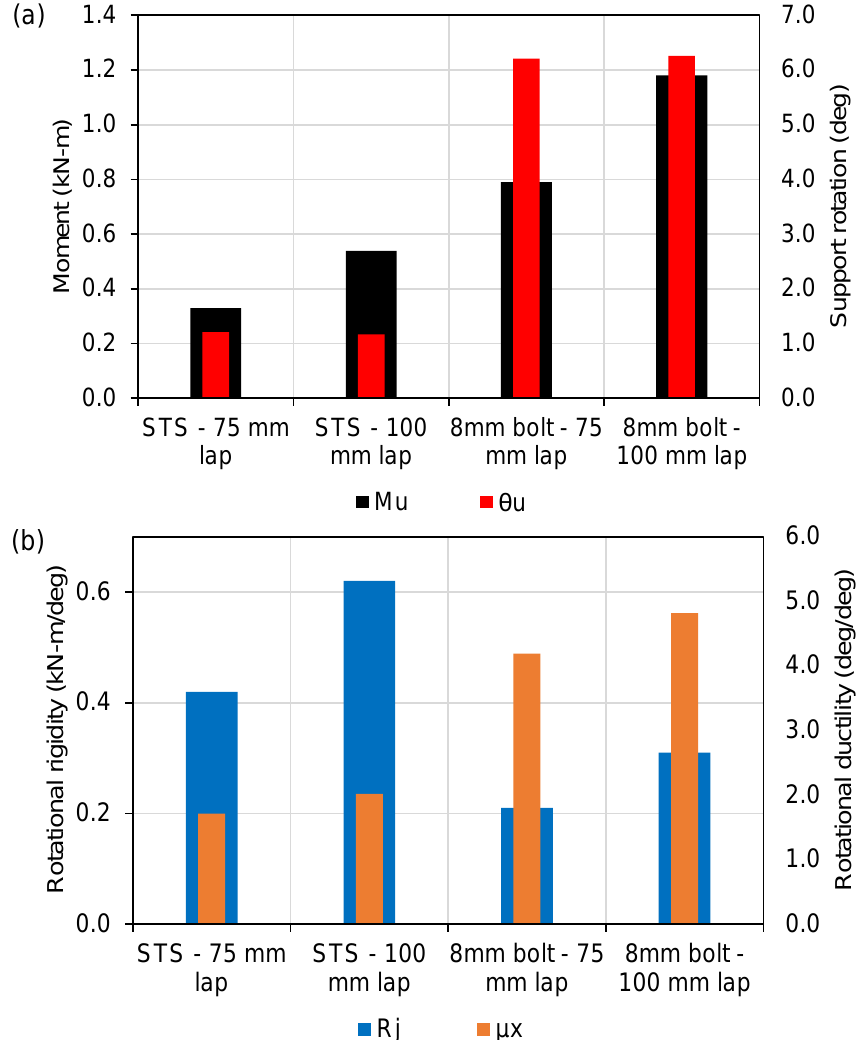
Figure 8. Comparison among the lap connections based on the characteristic values of ( a ) moment capacities and support rotations and ( b ) rotational rigidity and ductility.